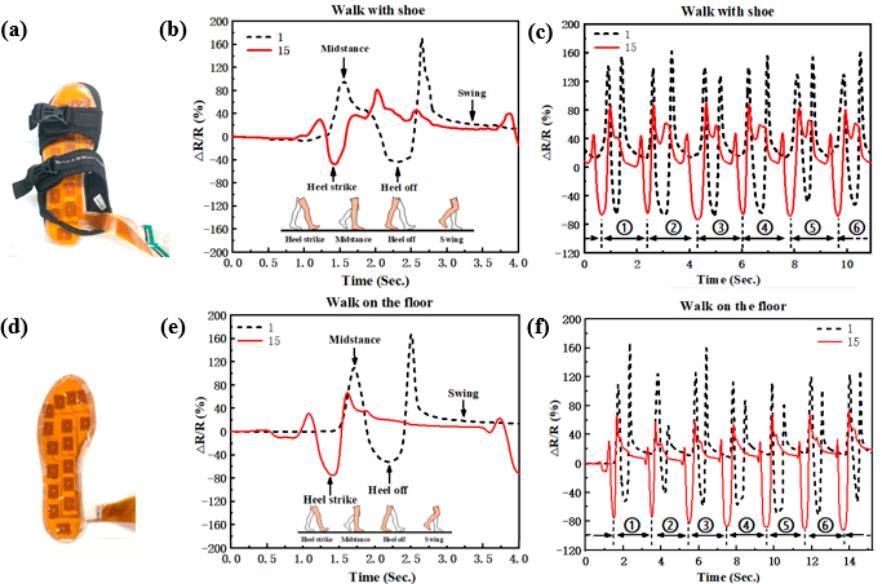
Figure 6. Gait cycle test using a commercial instrument, DM6510. ( a ) Diagram of walking with a shoe. ( b ) Resistance response of sensor points 1 and 15 when walking in shoes. ( d ) Diagram of walking on the floor. ( e ) Resistance response of sensor points 1 and 15 when walking on the floor. ( c , f ) Gait cycle test while walking in shoes and walking on the floor, respectively.